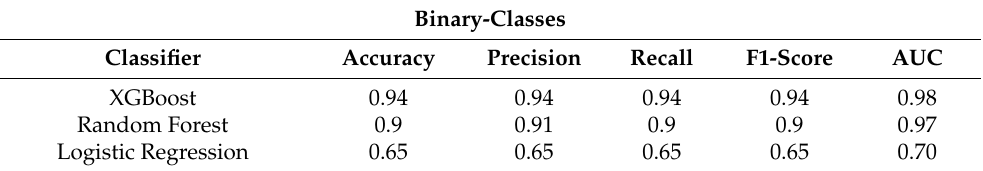
Table 4. Models’ binary-class performances.